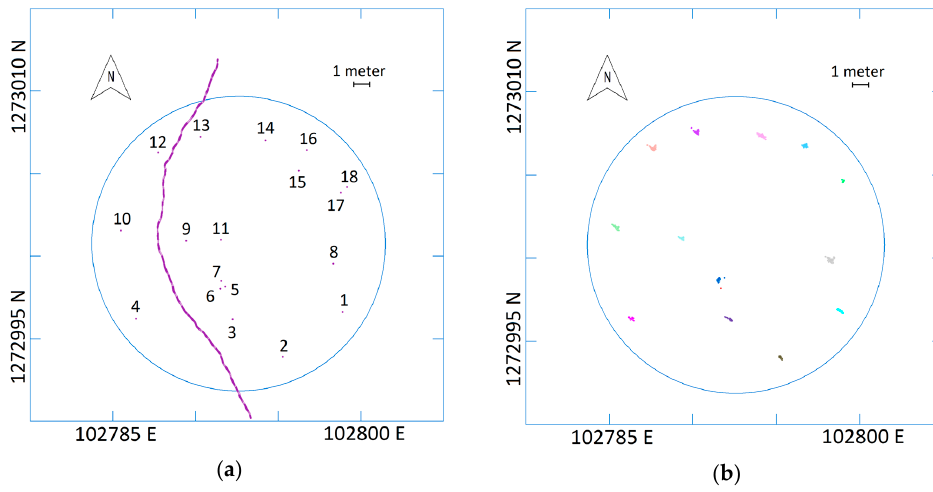
Figure 6. The walking path (purple line) during data capture and field measured position of the trees are shown in ( a ). In ( b ), all estimated center points are shown. Each tree stem center point is colored by a unique color for each tree.